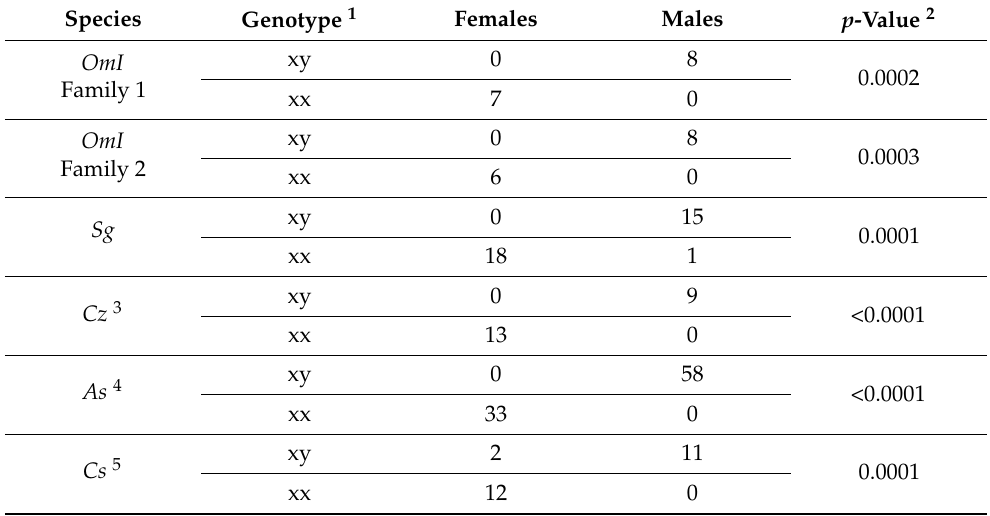
Table 4. Association of sex with the figla-like sequence in two O. mossambicus ( OmI ) families, S . galilaeus ( Sg ), C . zillii ( Cz ), and Amherst ( As ) and Chitralada ( Cs )